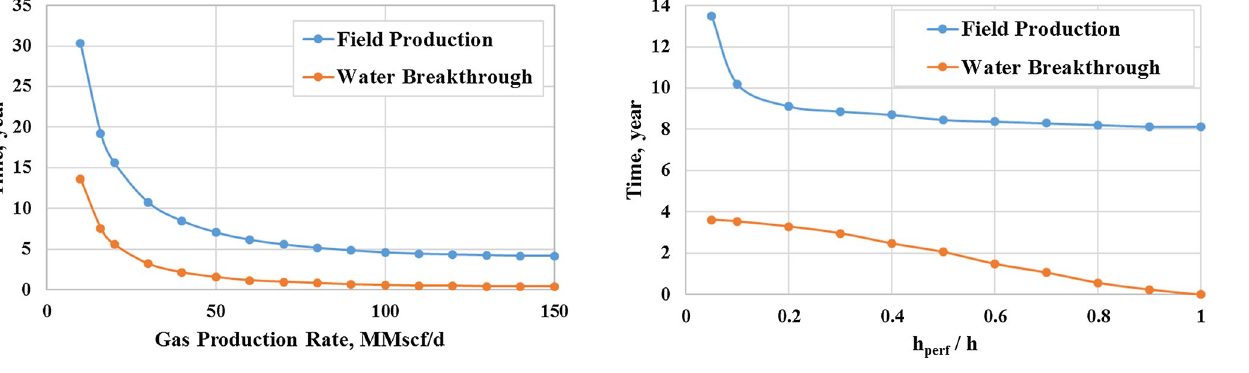
Fig. 23 Field production life and water breakthrough time for differ- ent gas production rates